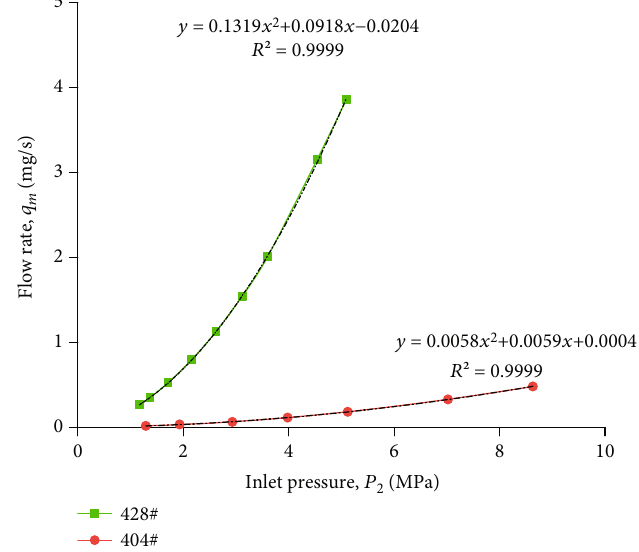
Figure 4: Shale gas fl ow characteristic